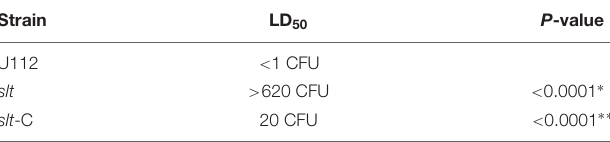
TABLE 2 | Lethal dose calculations for intranasal infection with F. novicida strains. Strain